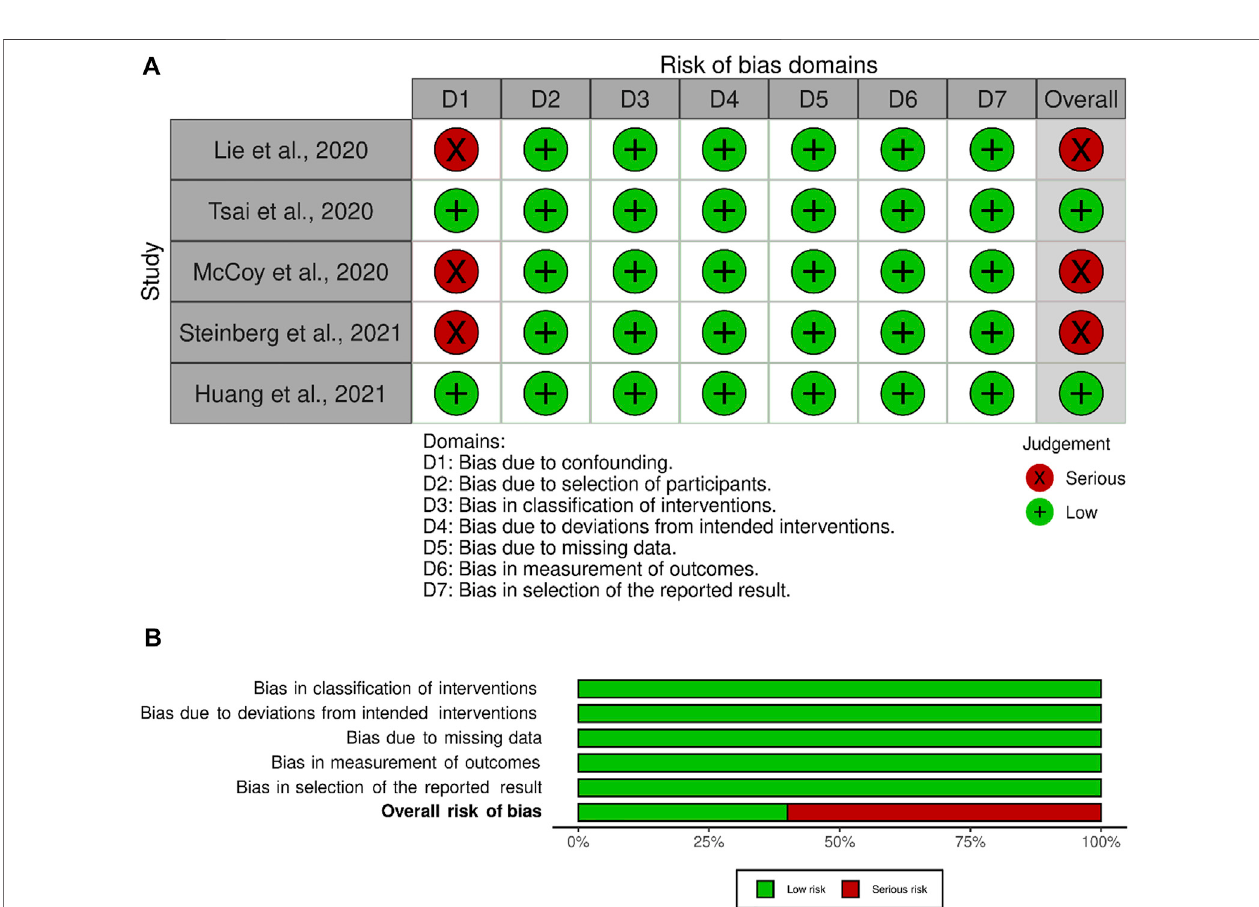
FIGURE 3 | Bias Reporting, (A) Bias domains for ROBINS-I for the included studies. (B) Total score for each ROBINS-I score.